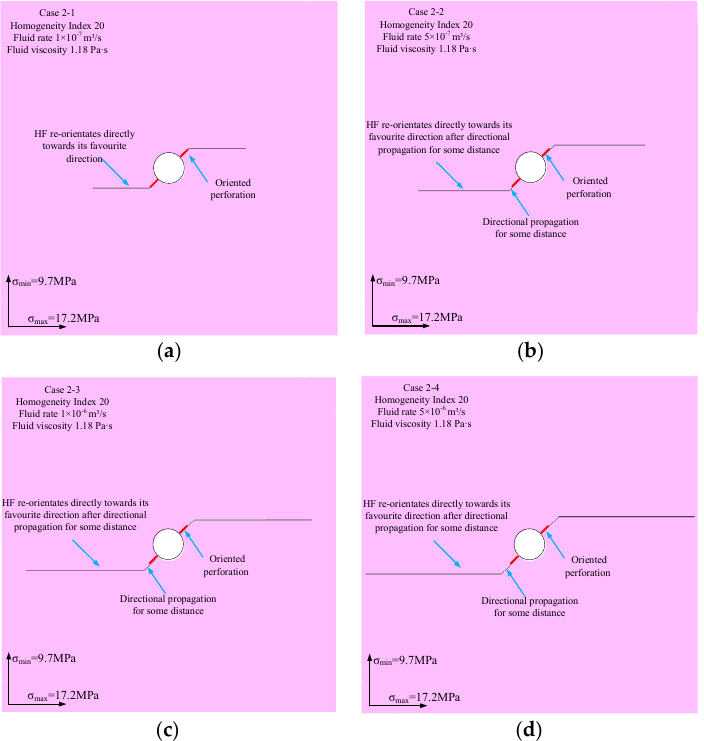
Figure 8. The relationship between HF re-orientation and fluid rate when the homogeneity index is equal to 20: ( a ) fluid rate is 1 × 10 − 7 m³/s; ( b ) fluid rate is 5 × 10 − 7 m³/s; ( c ) fluid rate is 1 × 10 − 6 m³/s; ( d ) fluid rate is 5 × 10 − 6 m³/s.